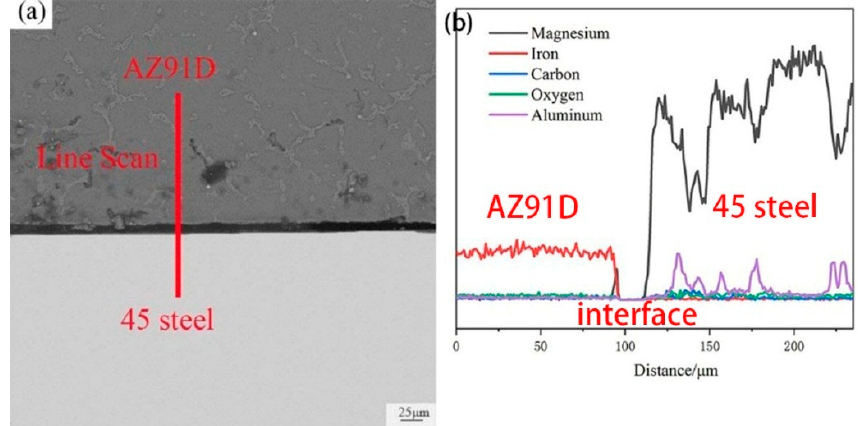
Figure 10. ( a )The SEM image of the cross-section images of bare-steel/AZ91D bimetallic material; ( b ) EDS line scan of bare-steel/AZ91D interface marked in (a).